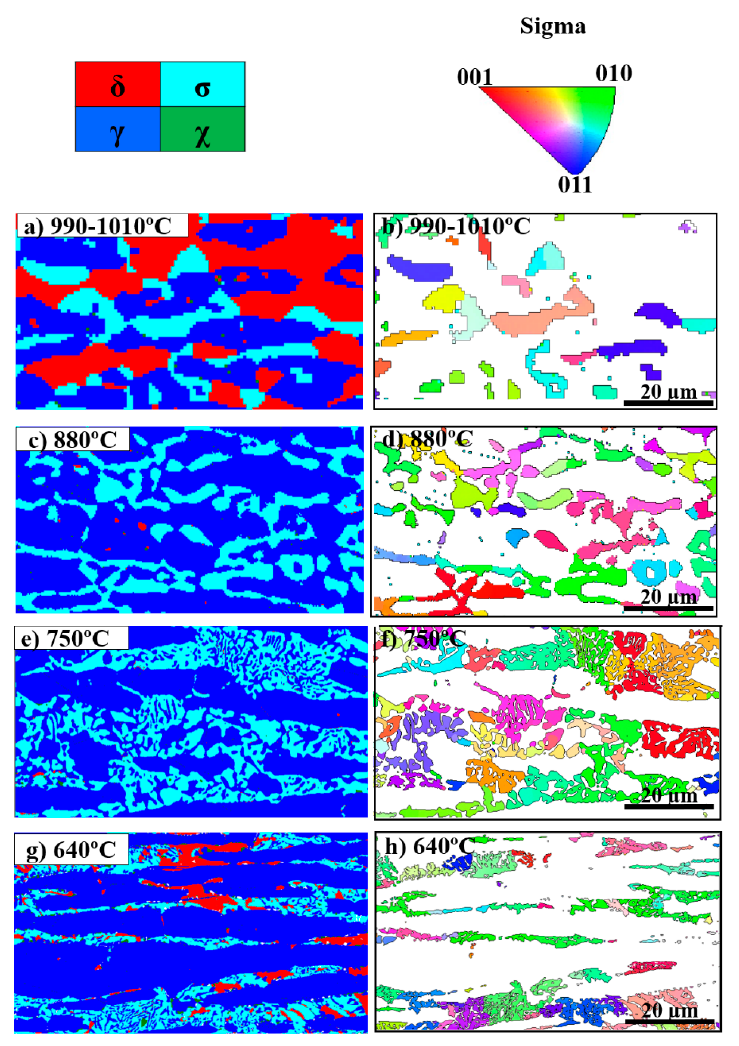
Figure 4. EBSD phase ( left ) and inverse pole figure (IPF) ( right ) maps showing sigma phase ( σ ) precipitating at different temperatures. The morphology of σ changed from blocky to coral-shaped with decreasing temperature. The phase and pole figure map at ( a , b ) 990–1010 °C, ( c , d ) 880 °C, ( e , f ) 750 °C, and ( g , h ) 640 °C.